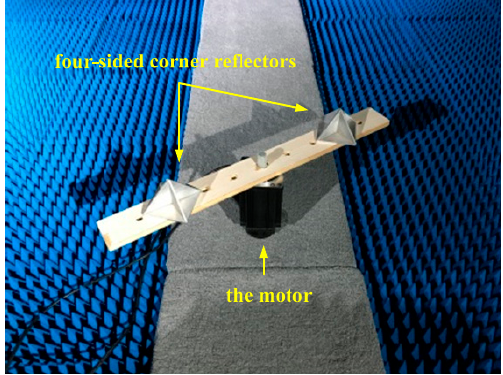
Figure 5. The rotating targets.